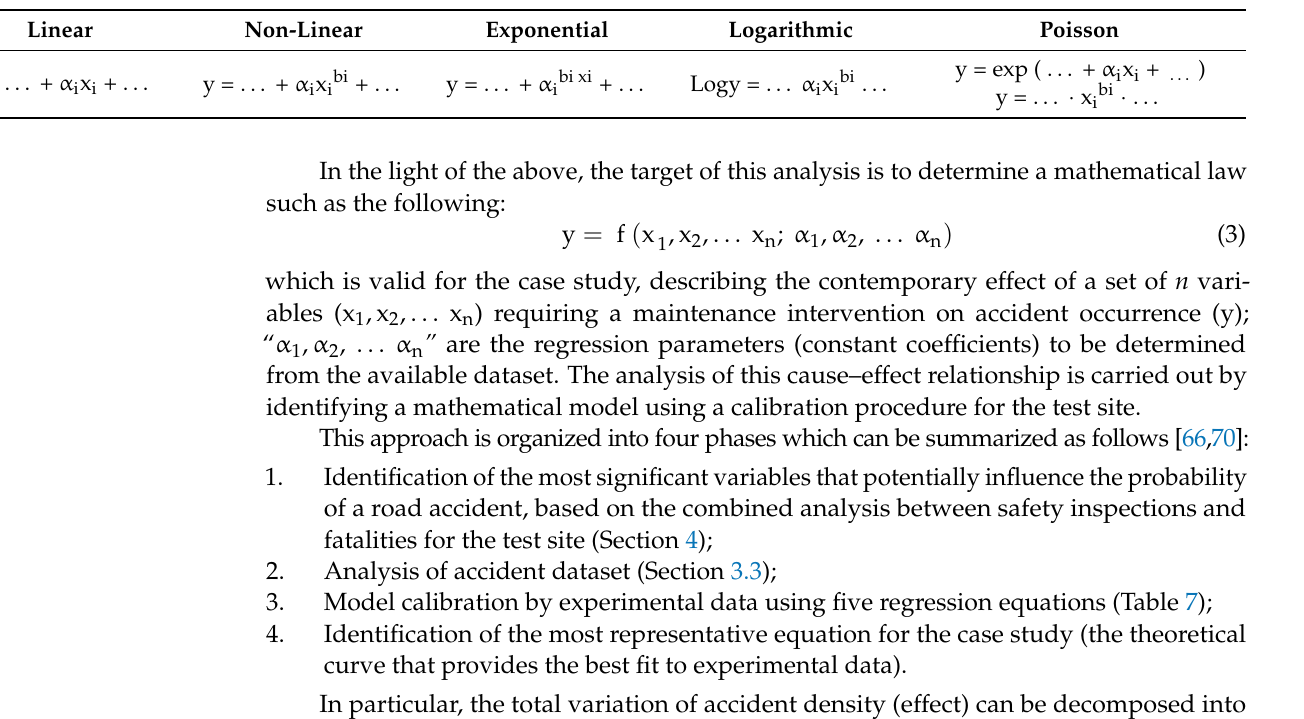
Table 7. Elementary forms of model